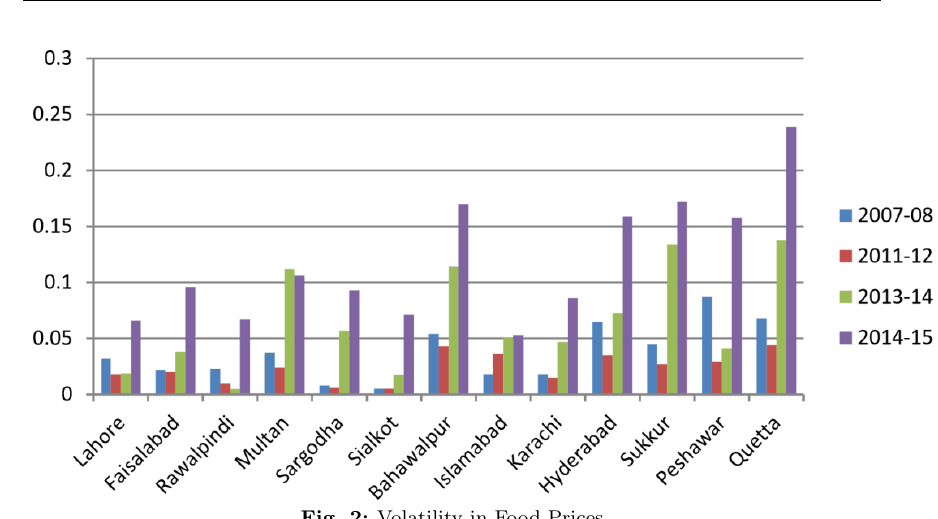
Fig. 2: Volatility in Food Prices